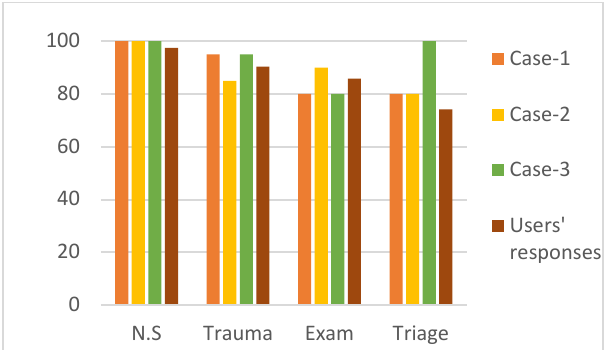
Fig. 9. Comparison of users’ responses and simulation results for the most used spaces of emergency